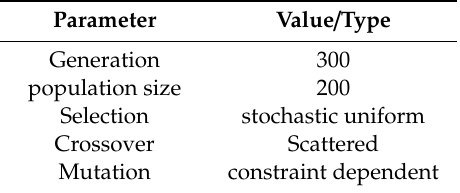
Table 3. Genetic Algorithm (GA) parameter settings.